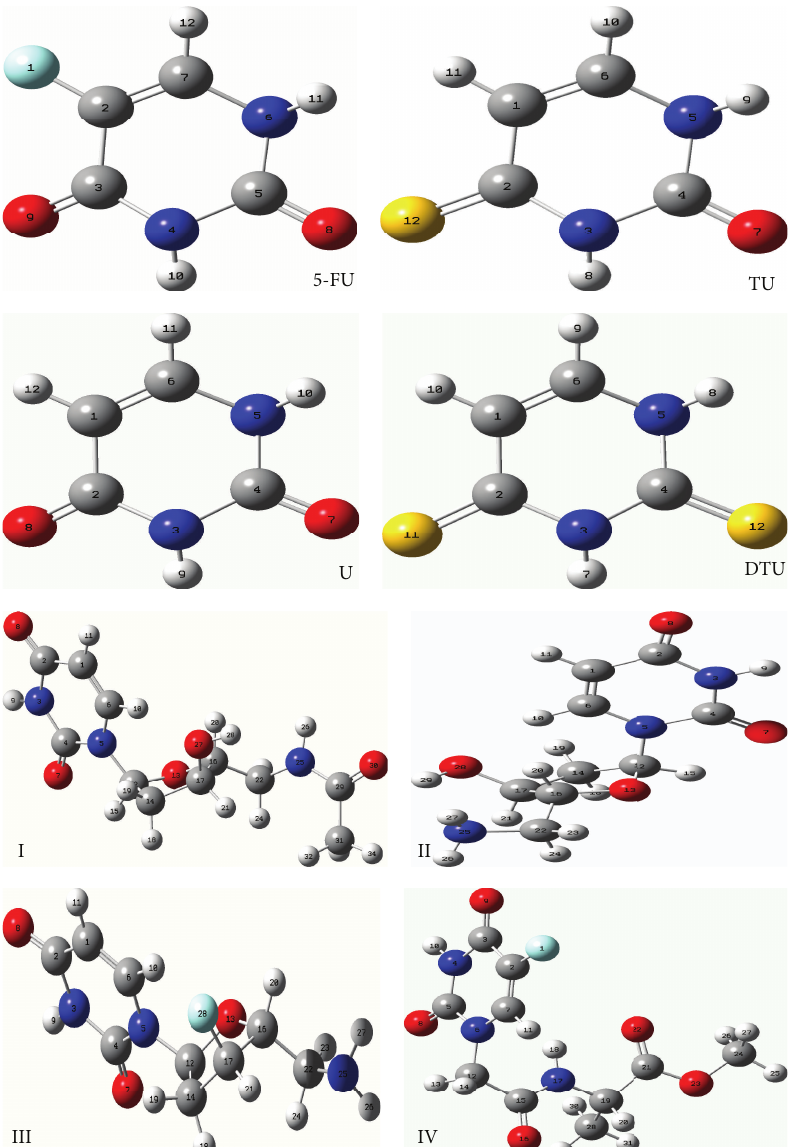
Figure 1: Structure and labeling of the molecules studied (blue, gray, light blue, red, and white spheres are representing nitrogen, carbon, fluorine, oxygen, and H atoms,